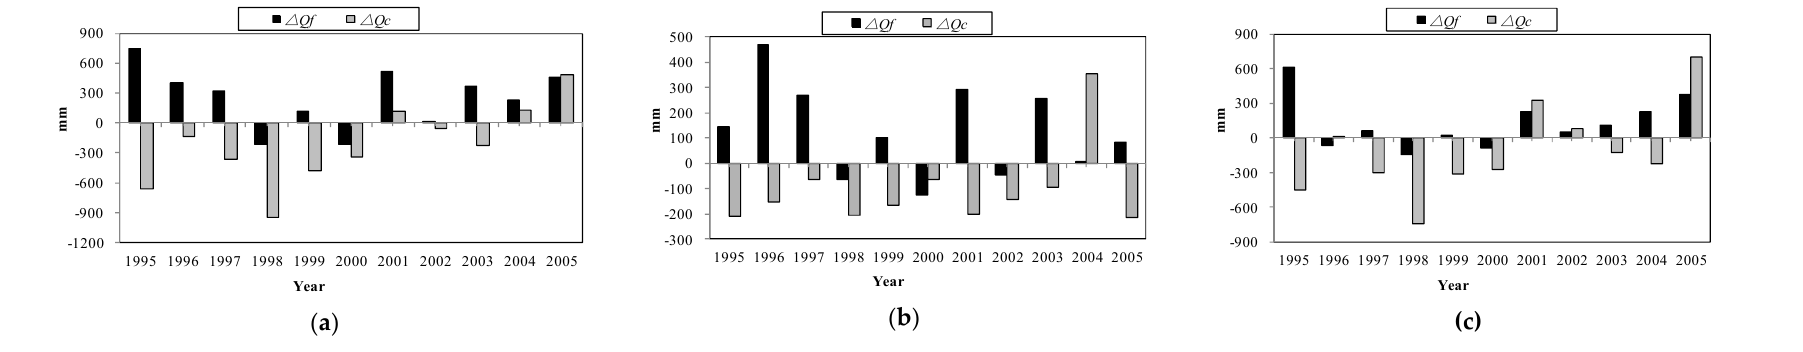
Figure 8. Streamflow variation attributed to forest disturbances ( △ Q f ) and climate variability ( △ Q c ) in ( a ) annual; ( b ) dry season and ( c ) wet season. Table 6. Annual and seasonal streamflow variations to climate variability, forest disturbances and other factors in different phases.